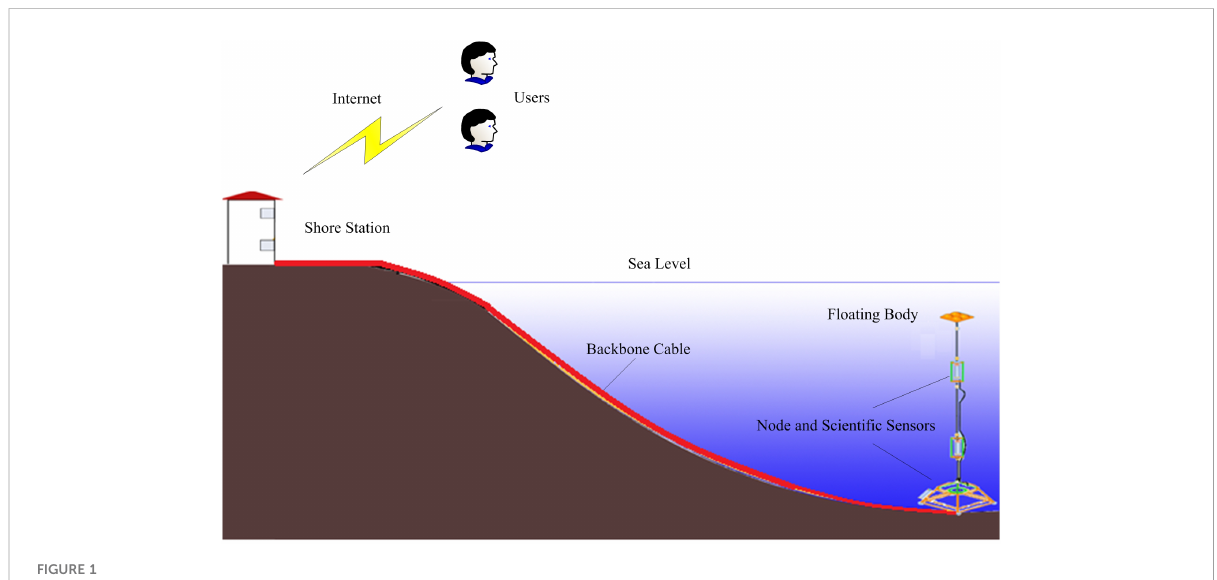
FIGURE 1 Overview of integrated monitoring system for DCOs